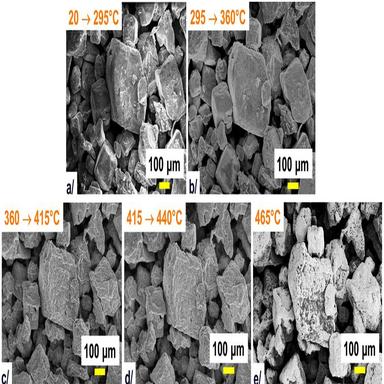
a/ Thermally-induced transitions of LiOH powder during the heating step under secondary vacuum with b/−d/ a highlight of the intermediate surface of LiOH, and e/ at the beginning of the surface conversion into Li2O.